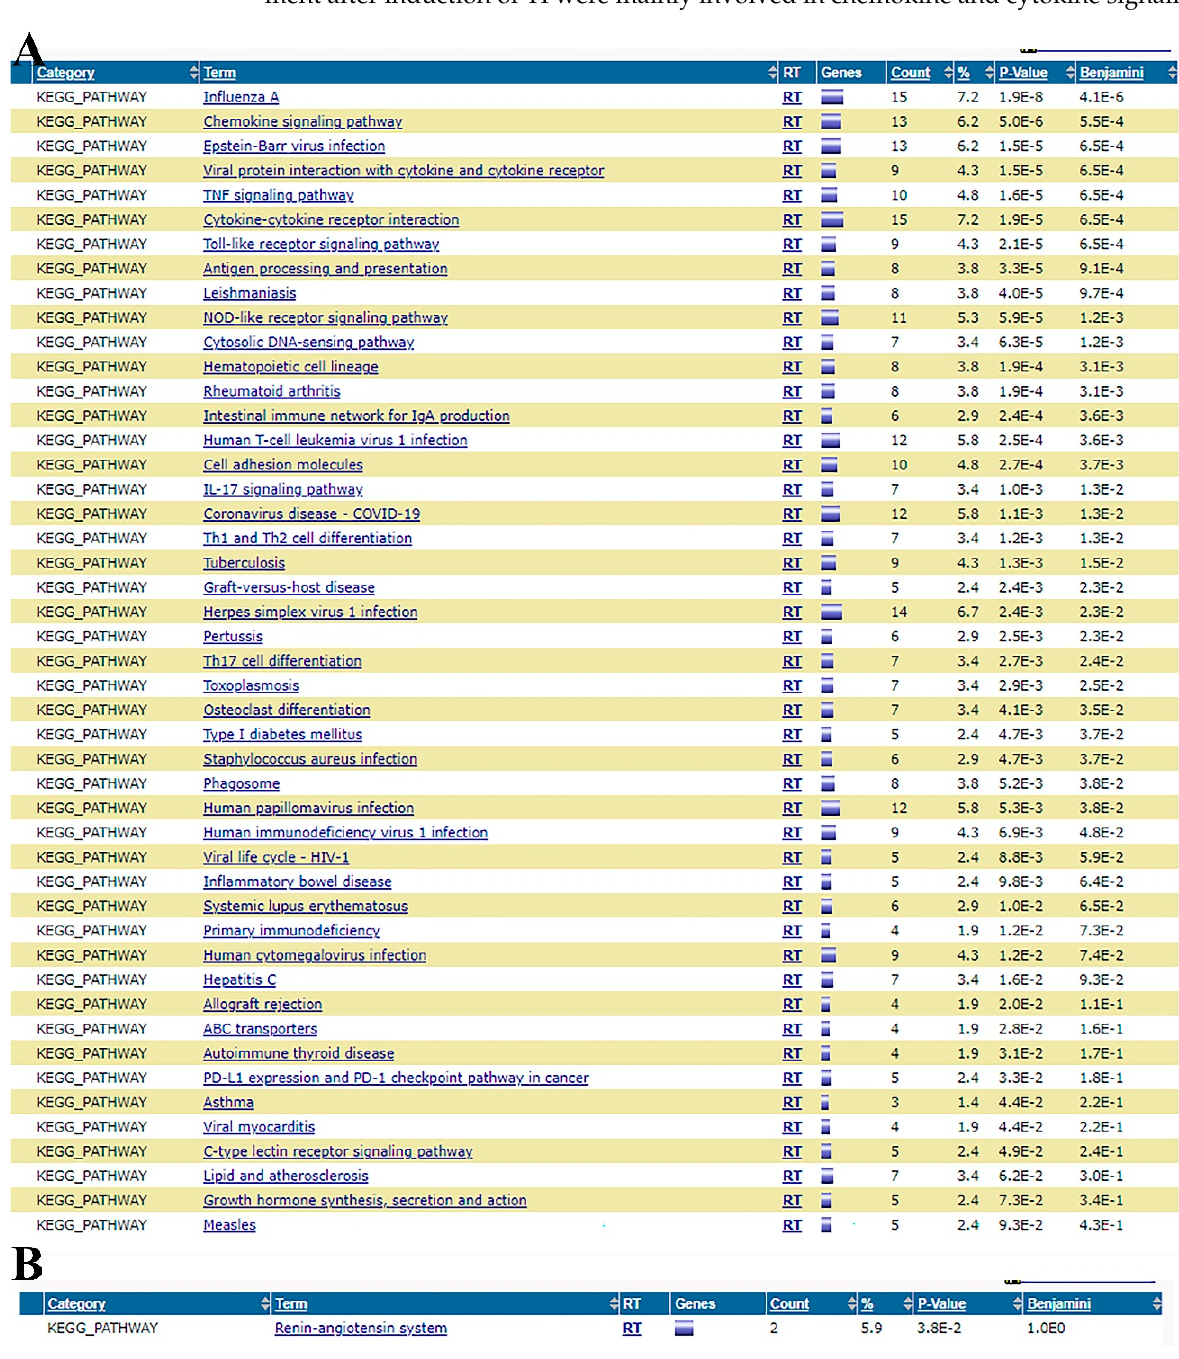
Figure 8. Analysis of KEGG pathways related to TI: ( A ) Functional pathways were downregulated by OLNZ treatment after TI; and ( B ) Upregulated by OLNZ treatment after TI.